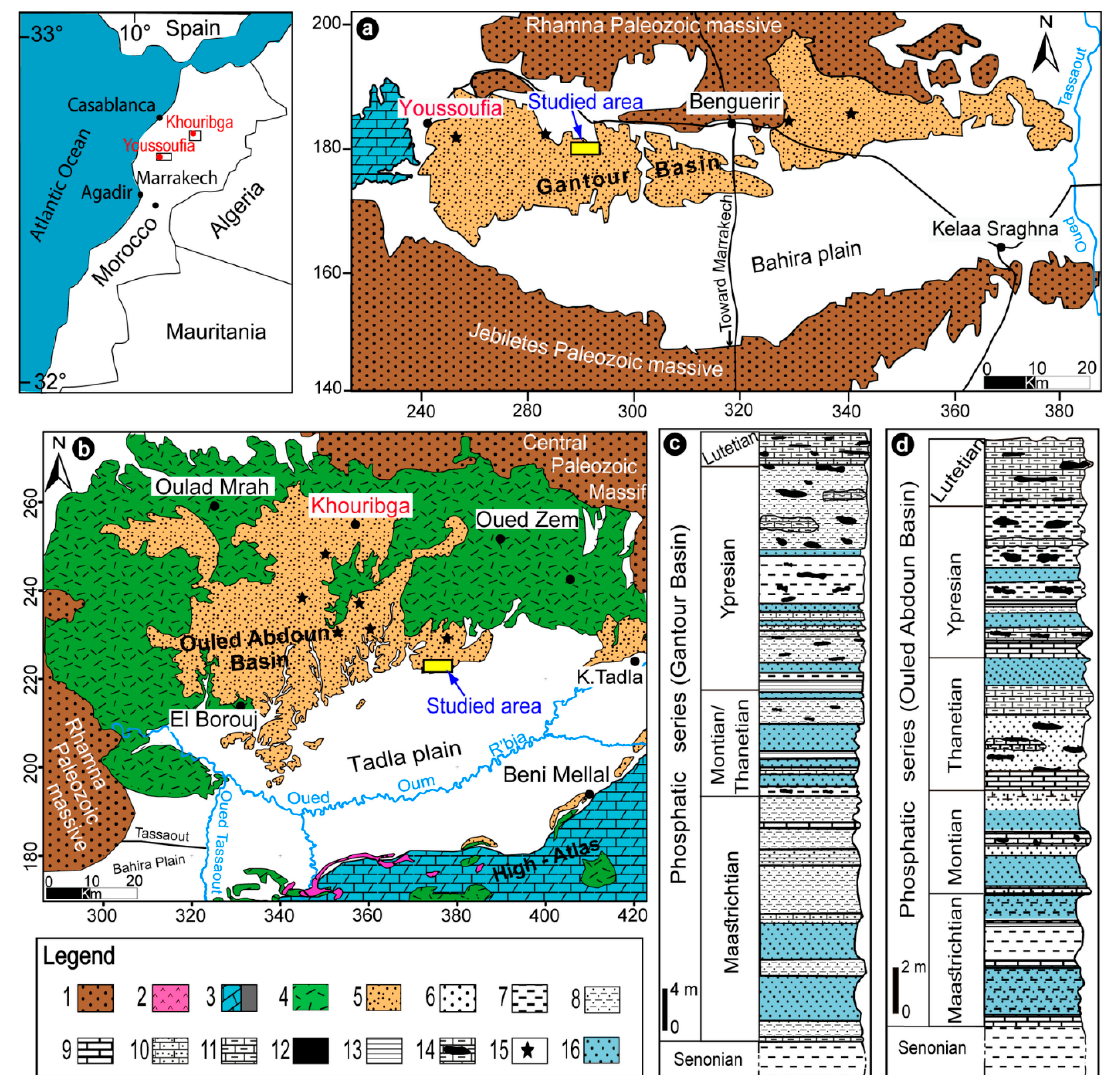
Figure 1. Location and geology sitting of study areas. ( a ) Geological map of the Gantour Basin (modified after [8]); ( b ) Geological map of the Ouled Abdoun Basin (after [9]); ( c ) Lithological columns of the phosphatic series in Gantour Basin showing the main groundwater aquifers; ( d ) Lithological columns of the phosphatic series in Ouled Abdoun Basin showing the main groundwater aquifers; 1: Paleozoic; 2: Trias; 3: Jurassic; 4: Cretaceous except Maastrichtian; 5: Maastrichtian–Eocene; 6: Uncemented phosphates, 7: Marl; 8: Phosphatic marl; 9: Limestone; 10: Phosphatic limestone; 11: Marly limestone; 12: Silex; 13: Clay; 14: Marly-siliceous limestone; 15: Open-pit mine; 16: Aquifers. (N.B. Lambert kilometric coordinates projection for the north of Morocco).